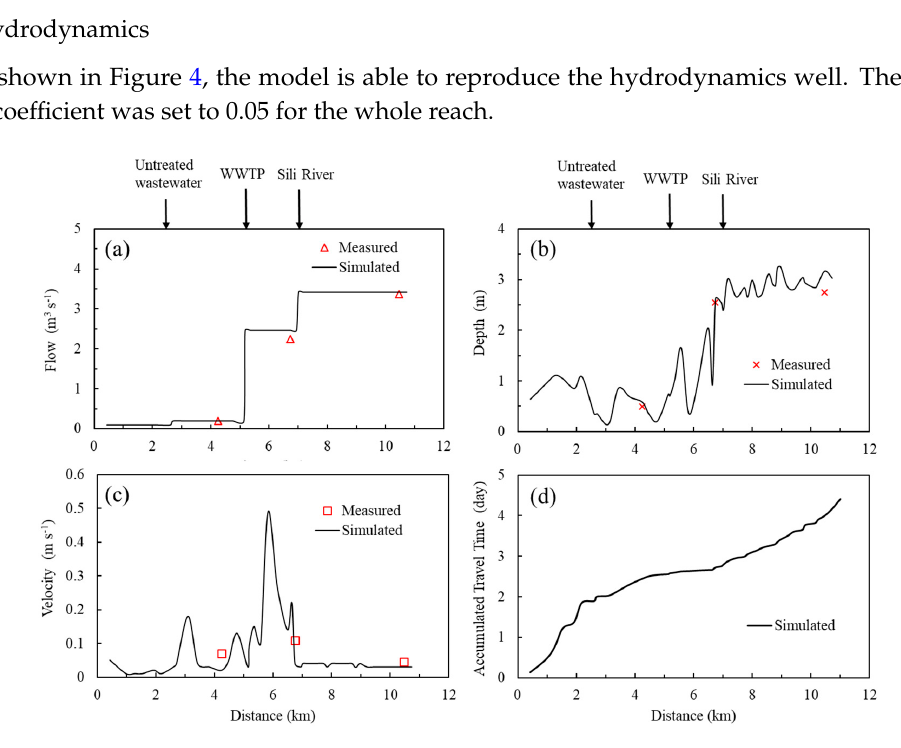
Figure 4. Measured and simulated hydrodynamic conditions in the Nanfei River. ( a ) Flow; ( b ) depth; ( c ) velocity and ( d ) accumulated travel time (only simulated).